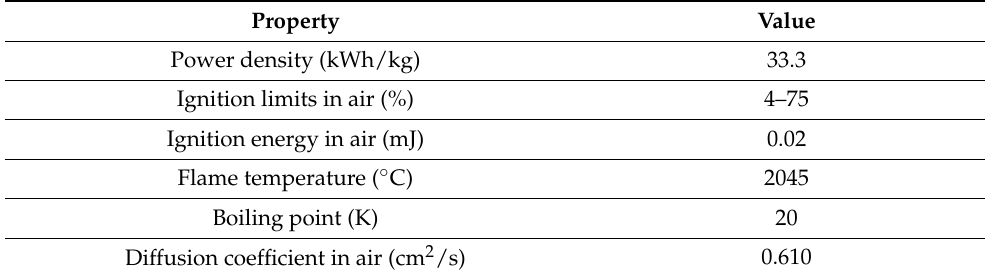
Table 5. Hydrogen properties for safe and secure handling (reprinted with permission from ref. [66,69,77,78] Copyright 2022